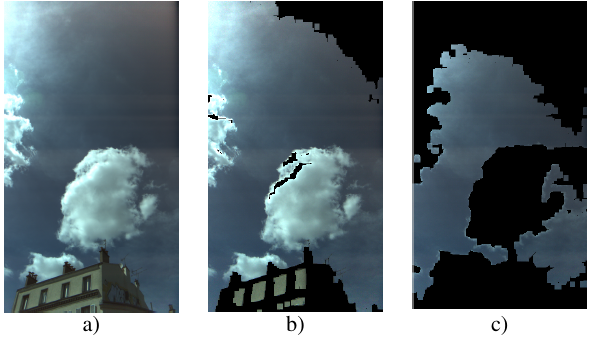
Figure 5: Result of sky+clouds (a) and blue sky (b)